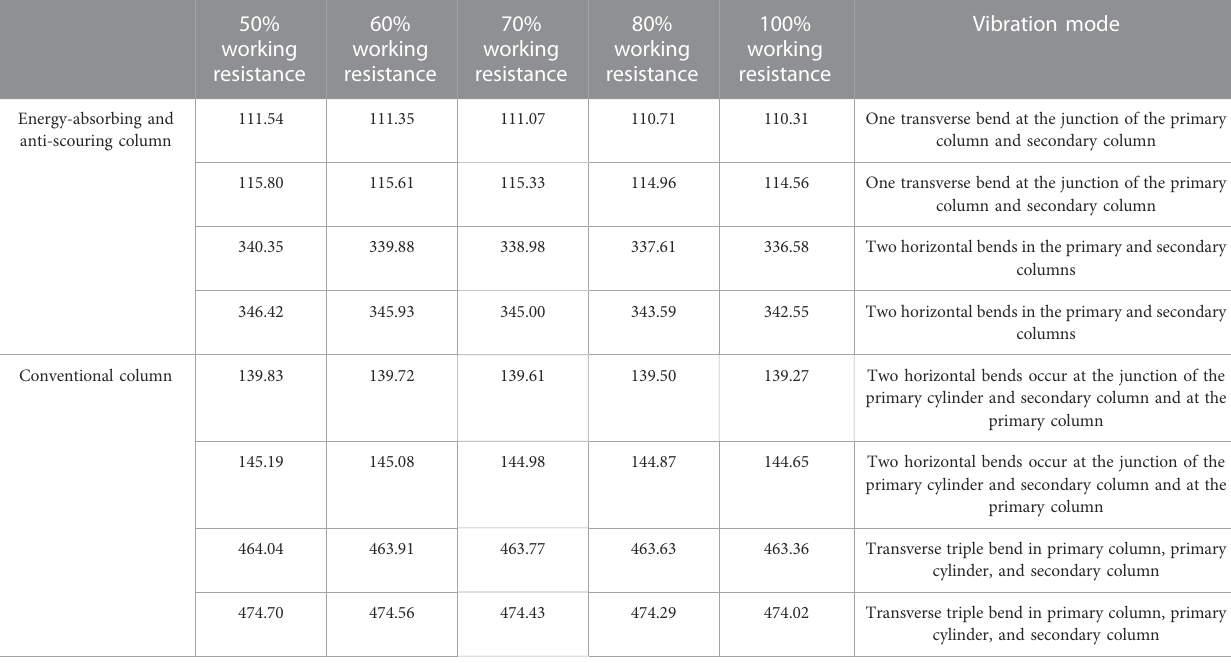
TABLE 10 Effect of different setting forces on column ’ s natural frequencies and vibration modes.